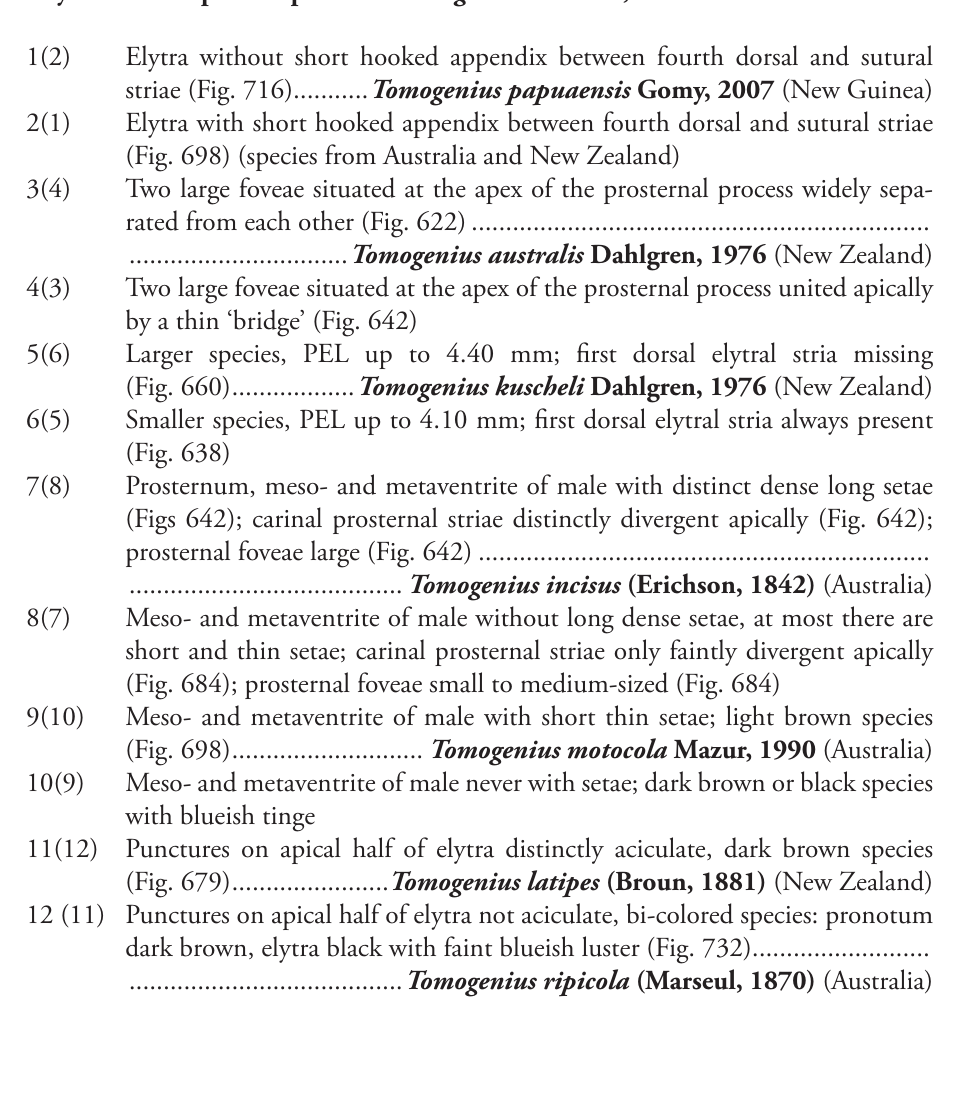
by a thin ‘bridge’ (Fig. 642)